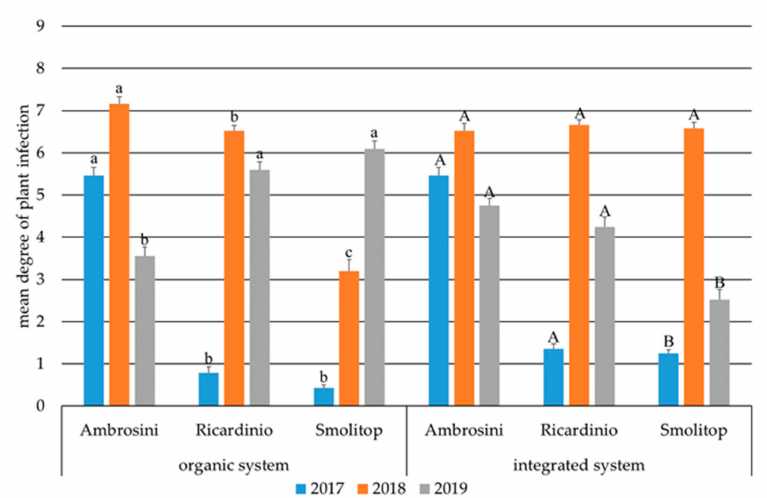
Figure 1. Plant infestation (mean ± SEM) with northern corn leaf blight of three maize varieties in the years 2017–2019 in two cultivation systems; different letters denote significant differences among varieties (Ambrosini, Ricardinio, Smolitop) in the same year for organic (lowercase letters) and integrated (capital letters) farming, according to the Kruskal–Wallis test at p ≤